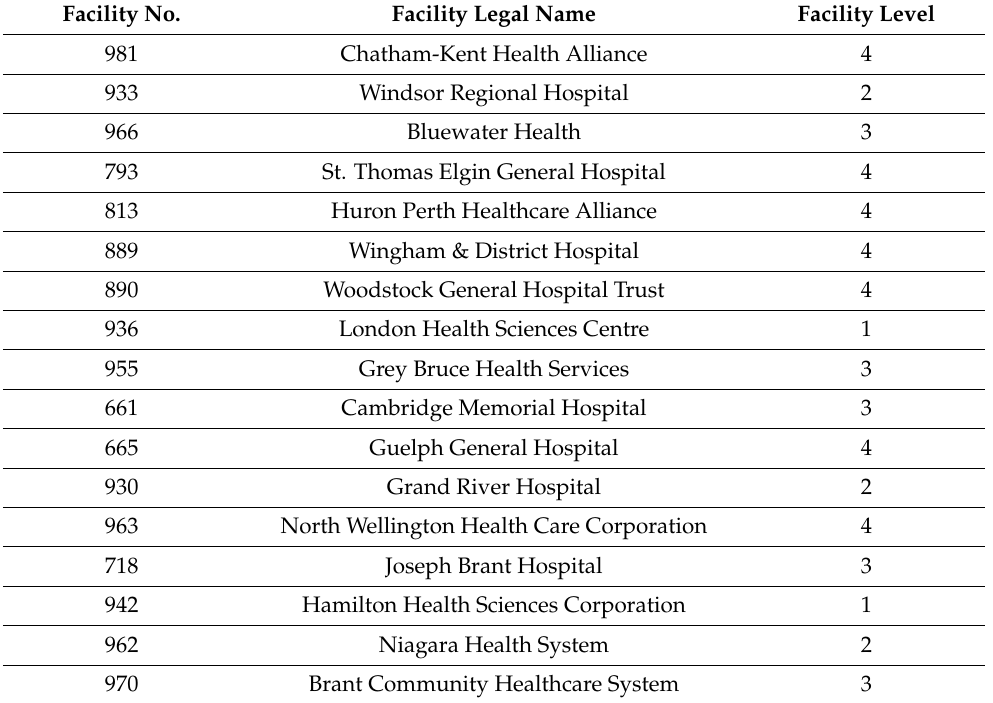
Figure A6. Definitions of facility levels for delivery of systemic therapy. © Cancer Care Ontario Systemic Treatment Provincial Plan 2014–2019 [16] (permission obtained from corresponding author). Table A5. List of facilities included and assigned facility level. Facility No. Facility